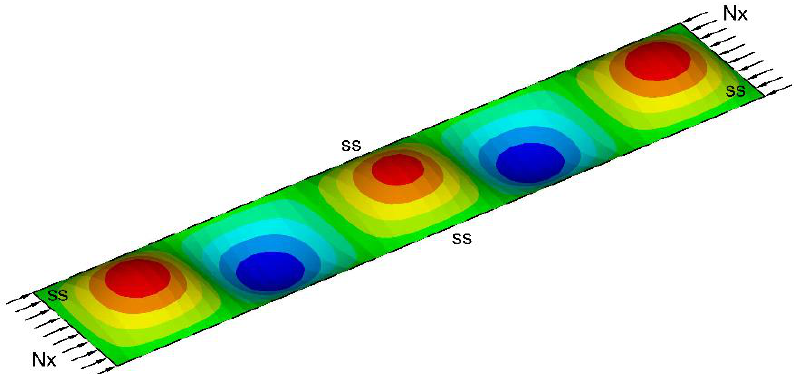
Figure 2. Long plate (a/b = 5) buckling eigen-form, representing the effect of buckling by squares for long plates.